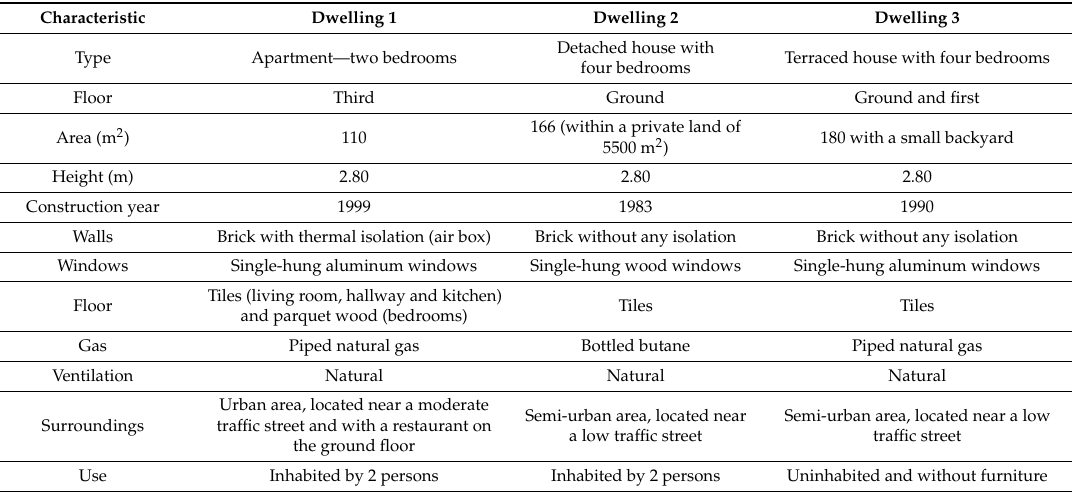
Table 1. Characteristics of the studied